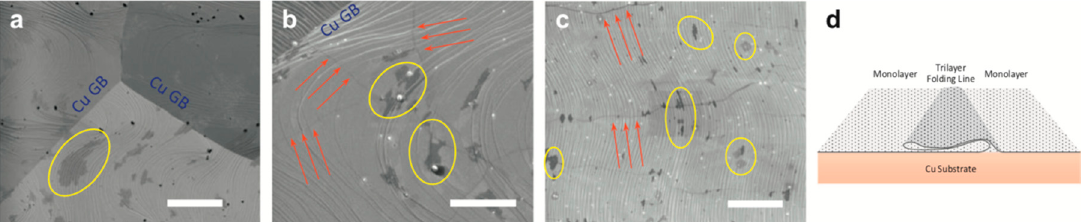
Figure 28. SEM images of CVD has grown graphene on Cu using di ff erent detectors ( a ) backscattering, ( b ) ETD and ( c ) TLD. Yellow circles present few-layer graphene, red arrows show the graphene folding lines and the blue Cu GB text present a Cu grain boundary. Scale bars for a–c are 5 µ m; ( d ) a schematic illustration of a folding line (reprinted with permission from [138]).